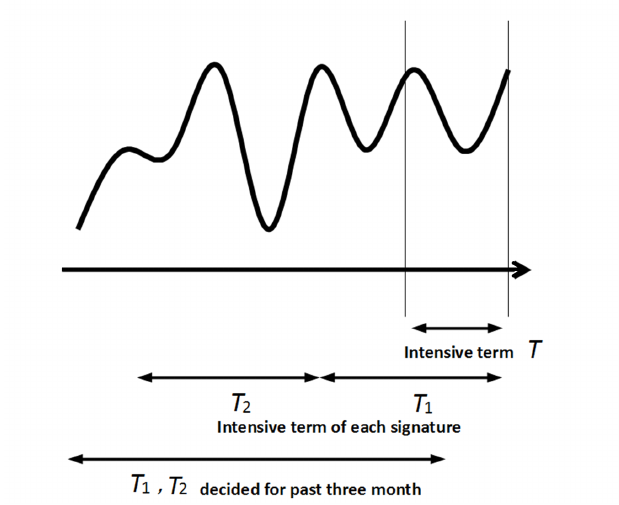
Figure 1: Conceptual image of deciding intensive term.